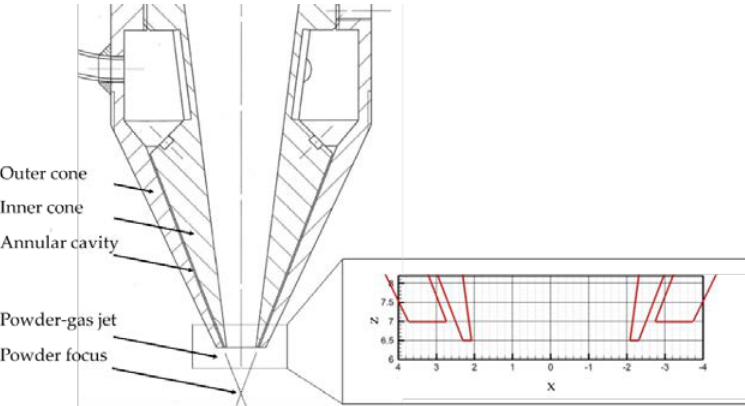
Figure 7. Schematic diagram of the powder nozzle and the annular cavity between the inner and outer cone of the continuous coaxial powder nozzle ILT-COAX 40-F [1]. Reprinted with permission from Ref [1]. Copyright 2020, Fraunhofer Verlag.